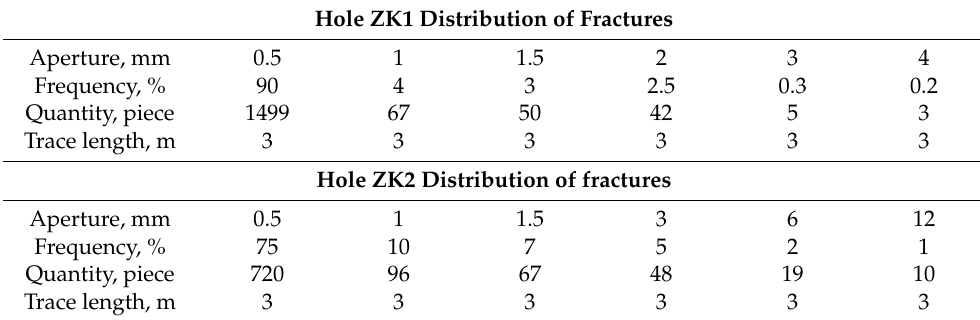
Table 3. Calculation of water flow in typical fracture gap widths of Groups I and II.